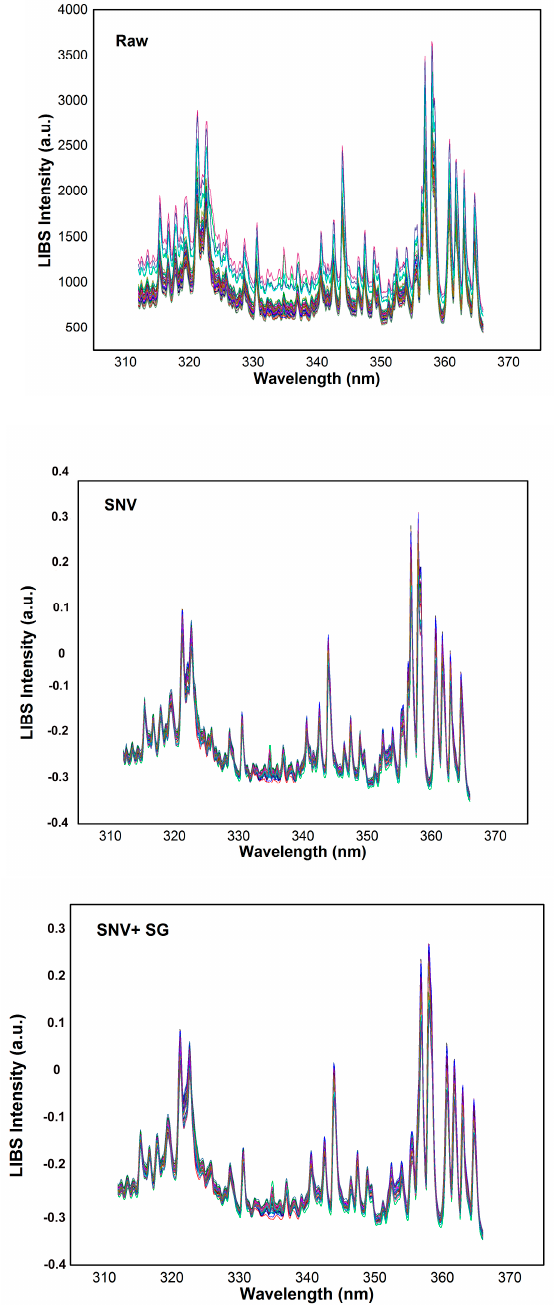
Figure 6. Raw, standard normal variate (SNV), and SNV + Savitzky–Golay (SG) LIBS spectra in a specific spectral region (310–365 nm).